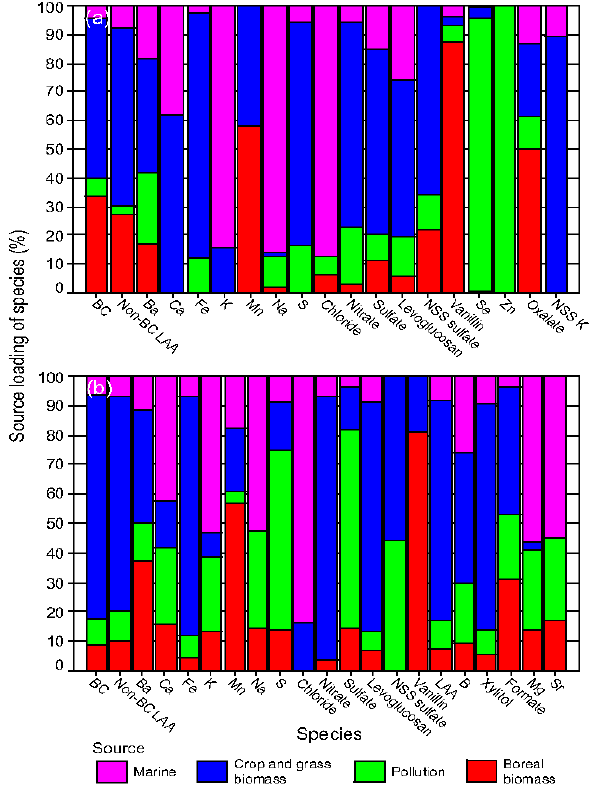
Fig. 2. (a) Source profiles for the 2008 data set. (b) Source profiles for the 2009 (Canadian) data